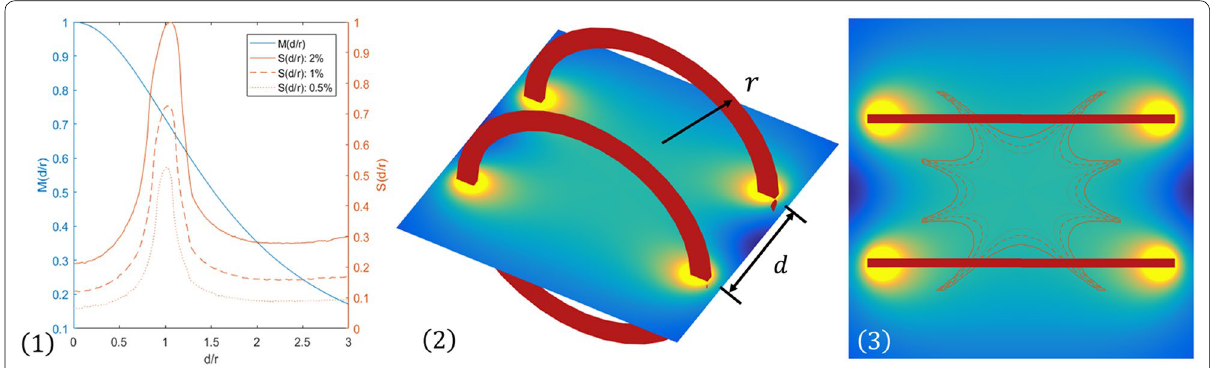
Figure 6 Optimization result for the loop-shaped coil pair inducing uniform magnetic